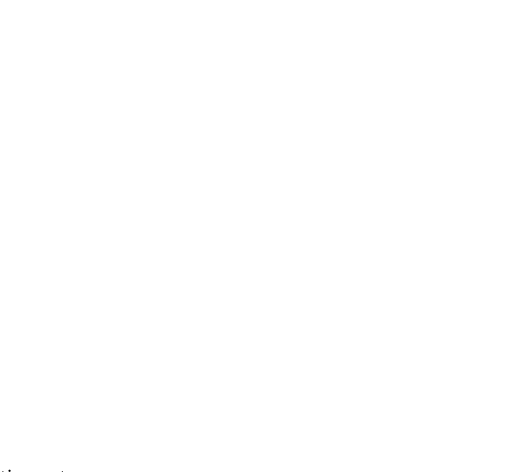
Table 1. Predicted of biological activity to prediction